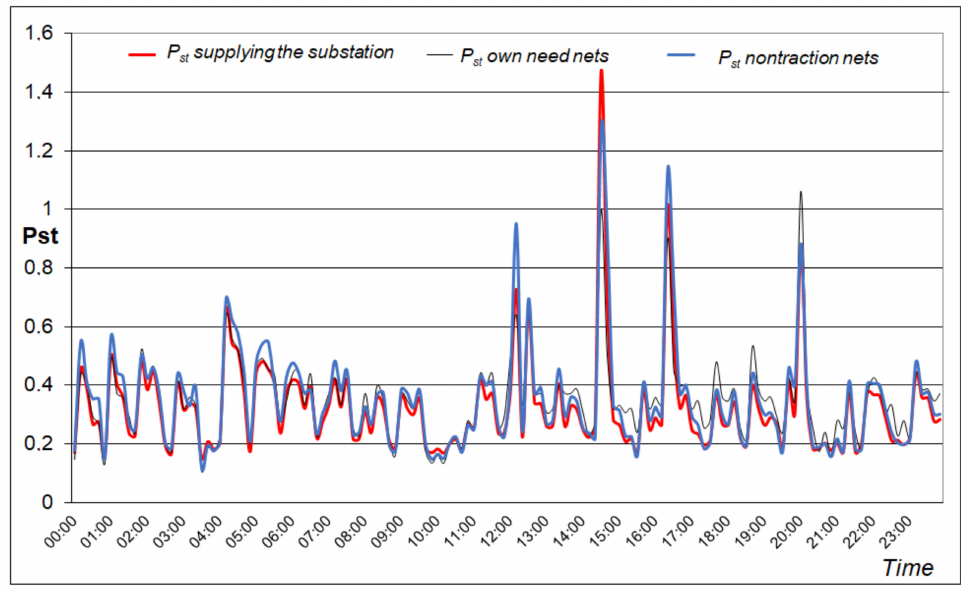
Figure 26. Changes light flicker coefficients recorded in the supply line to the substation, non-traction nets lines and auxiliary